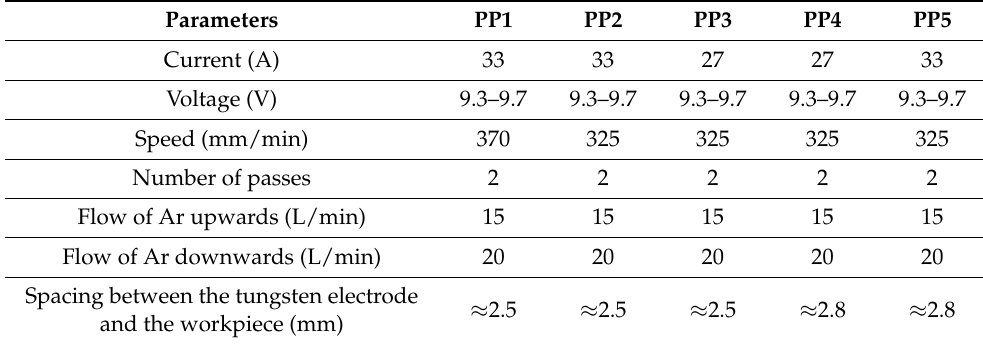
Table 2. Welding parameters of pre-tests